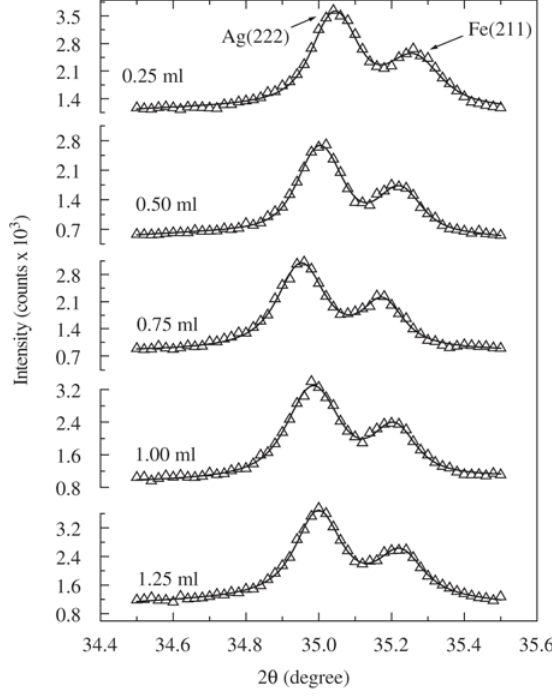
in the Fe Ag granular m 10 90 ac Figure 2. X-ray diffractogram of the Ag (222) and Fe (211) peaks of Fe Ag granular alloy, in different nitric acid concentrations. The 10 90 solid line was the fitting obtained using two Pseudo-Voigt functions.